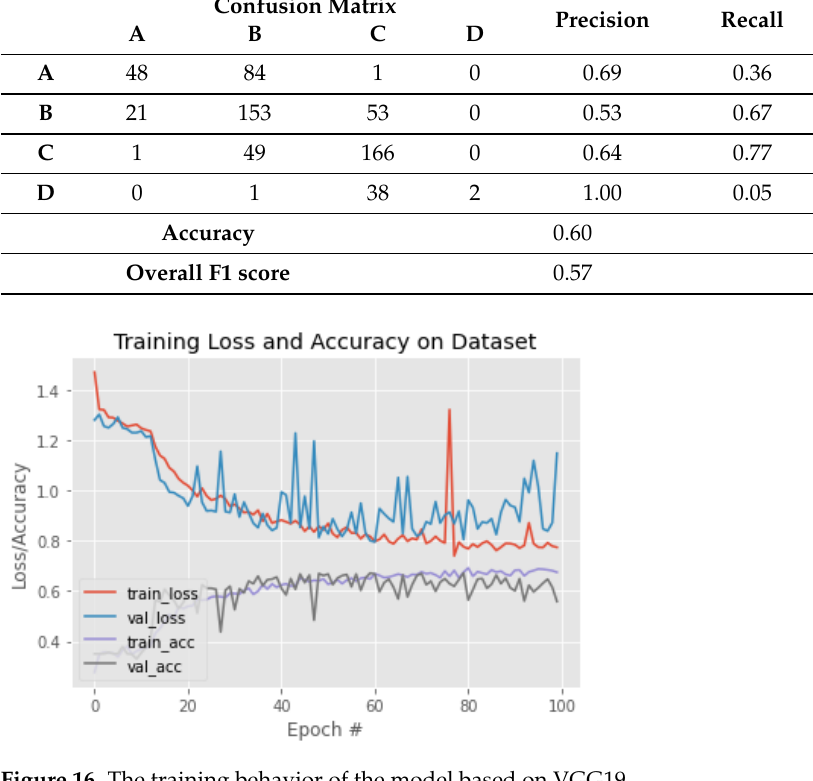
Figure 16. The training behavior of the model based on